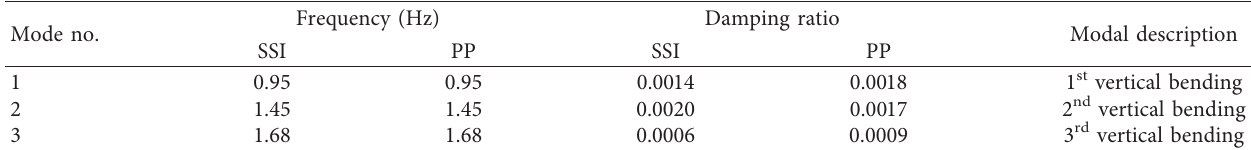
Table 2: First three identified dynamic characteristics of the bridge.